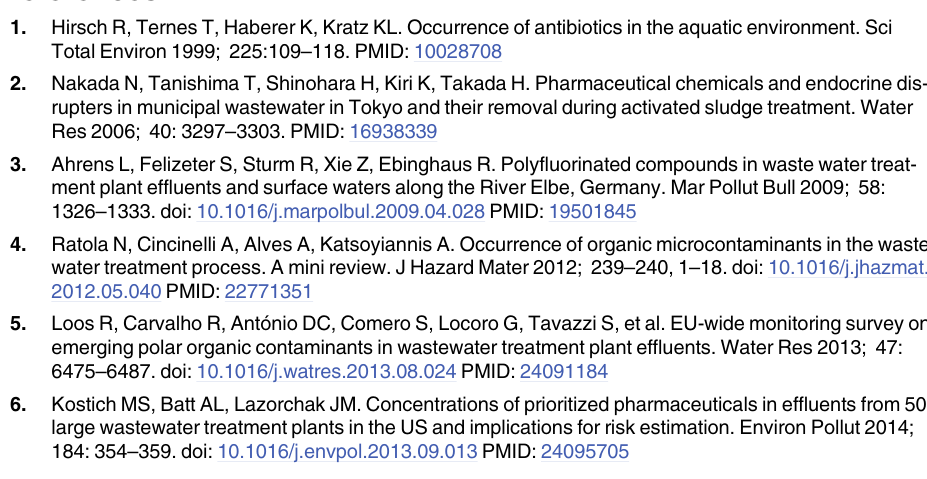
S1 Table. Primer sequences for real-time qRT-PCR. S2 Table. Estimated associations between resistance of E . Coli isolates to an antimicrobial agent and gene expression potential with other confounding variables in STP wastewater. 1 1 Estimated results were from a multivariable logistic regression analysis model. STP-2, pre- monsoon and Step 1, were assigned as the reference level for the variables of the facility, season and processing step, respectively. The asterisks shown to the P values shows the levels of statis- tical significance ( (cid:1) < 0.05, (cid:1)(cid:1) < 0.01). NA 2 : Estimate value and statistical significance for coeffi- cients of these variables were not available because of quasi-complete separation issue (Chloramphenicol). S3 Table. Chemicals which show interactions with more than three examined CYP genes in rats. Data were retrieved from the curated chemical-gene interaction data from the Compara- tive Toxicogenomics